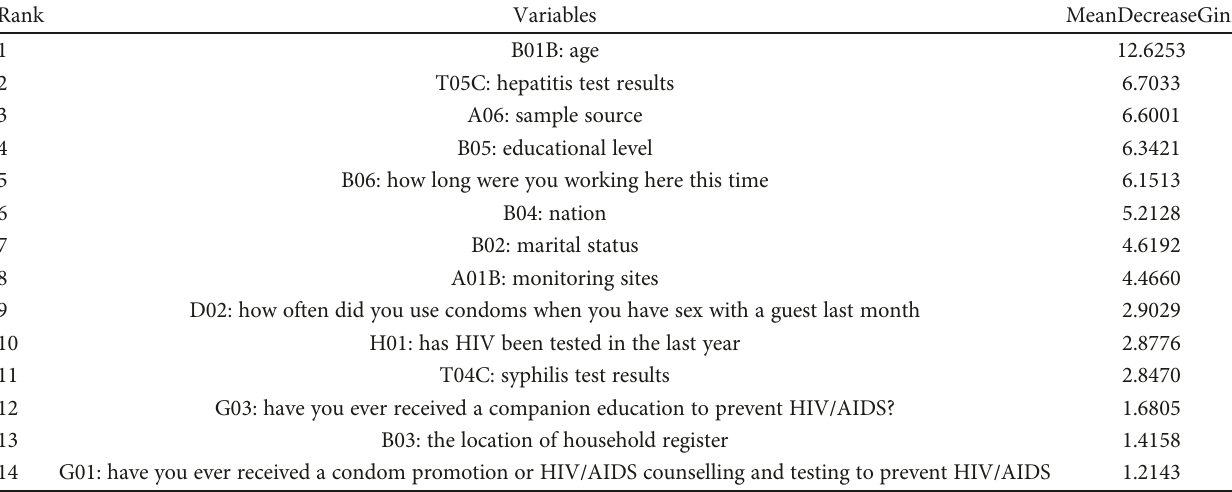
Table 7: Selection attributes used in models of FSW dataset.